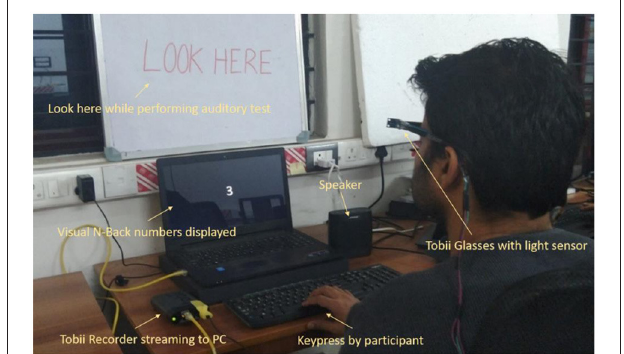
FIGURE 1 | Participant performing the visual N-back test.